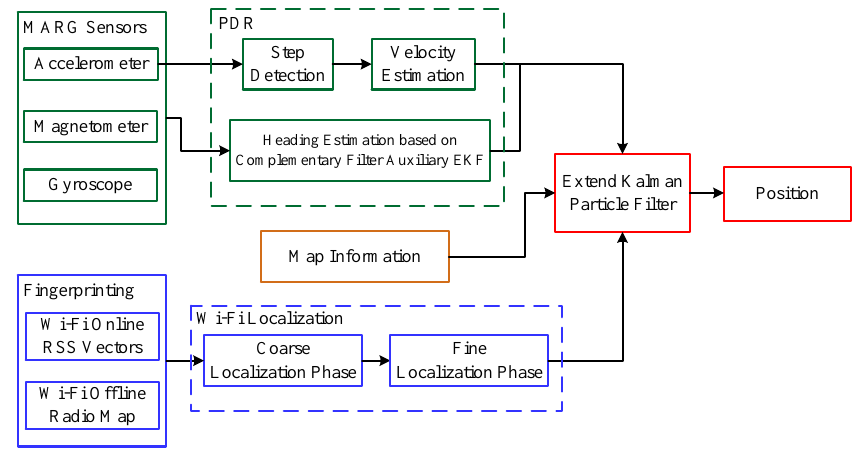
Figure 1. Architecture of the proposed